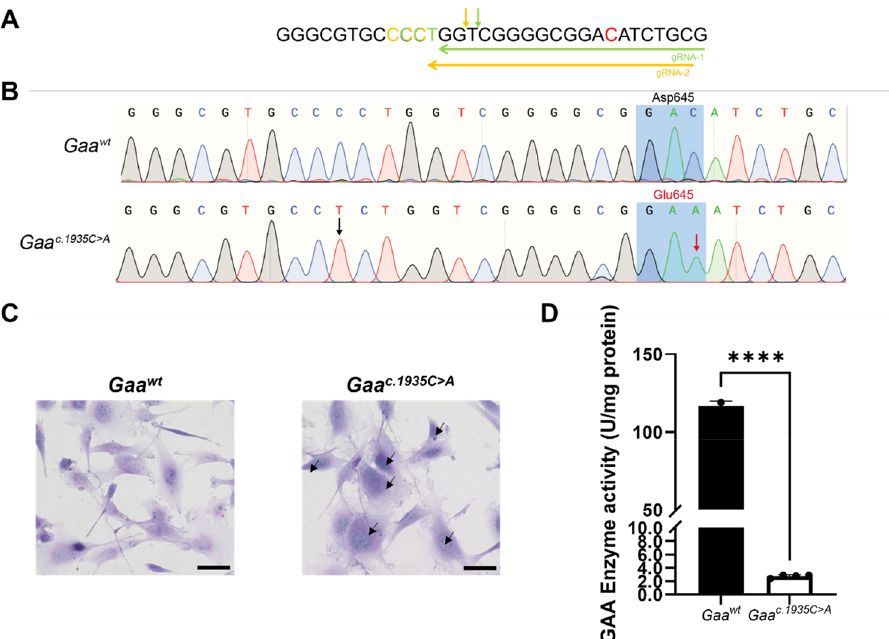
Figure 1. Generation and characterization of a Gaa c.1935C > A C2C12 myoblast clonal cell line. ( A ) Sequences of guide RNAs targeting the Gaa c.1935 target locus. Horizontal arrow indicates antisense guide RNAs used in this study. Protospacer adjacent motifs (PAM; NGG) are highlighted in color corresponding to the respective guide RNA. The Gaa c.1935 locus for targeted cytosine to adenine transversion is highlighted in red. ( B ) Sanger sequencing chromatograms of controls ( Gaa wt ) and clonal KI ( Gaa c.1935C > A ) C2C12 myoblast genomic DNA at the Gaa c.1935 locus. Black arrow indicates a synonymous mutation at the PAM site ( Gaa c.1920C > T ). Red arrow indicates the desired KI mutation ( Gaa c.1935C > A ). Gray shaded region indicates amino acid change from aspartic acid (Asp; GAC) to glutamic acid (Glu; GAA) at position 645. ( C ) Periodic-acid Schiff (PAS) staining of control ( Gaa wt ) and clonal KI ( Gaa c.1935C > A ) C2C12 myoblasts. Fixed cells were stained by PAS staining (purple-magenta) and counterstained by hematoxylin (blue). Only Gaa c.1935C > A KI myoblasts display significant accumulated PAS staining (see arrows). Representative images were captured on a bright-field microscope at 20 × objective magnification. Scale bar represents 50 µm. (D) GAA enzymatic activity in Gaa wt and Gaa c.1935C > A C2C12 myoblasts. Very low GAA activity (~ 2.3% of wt) was measured in Gaa c.1935C > A C2C12 myoblasts compared to Gaa wt C2C12 myoblasts. GAA enzymatic activity was measured using a fluorometric 4-MU α-d-glycoside assay and normalized to total amount of sample protein. Data generated from three independent experiments are shown as mean ± SD. Comparisons were analyzed with unpaired one-tailed t -tests. **** p <